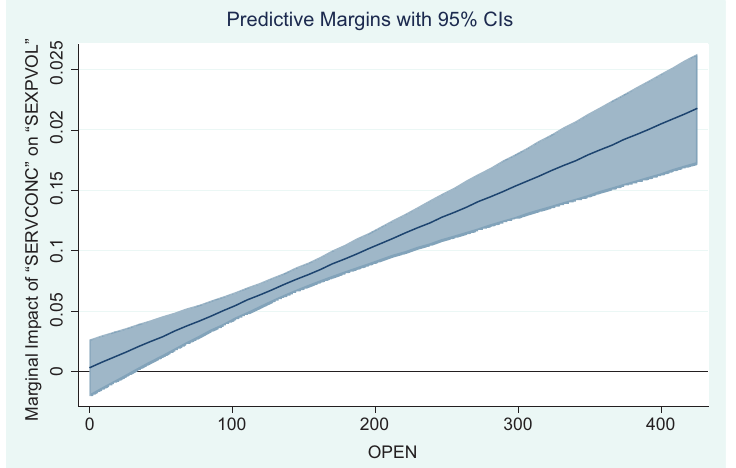
Figure 3. Marginal impact of “ SERVCONC ” on “ SEXPVOL ” , for varying values of “ OPEN